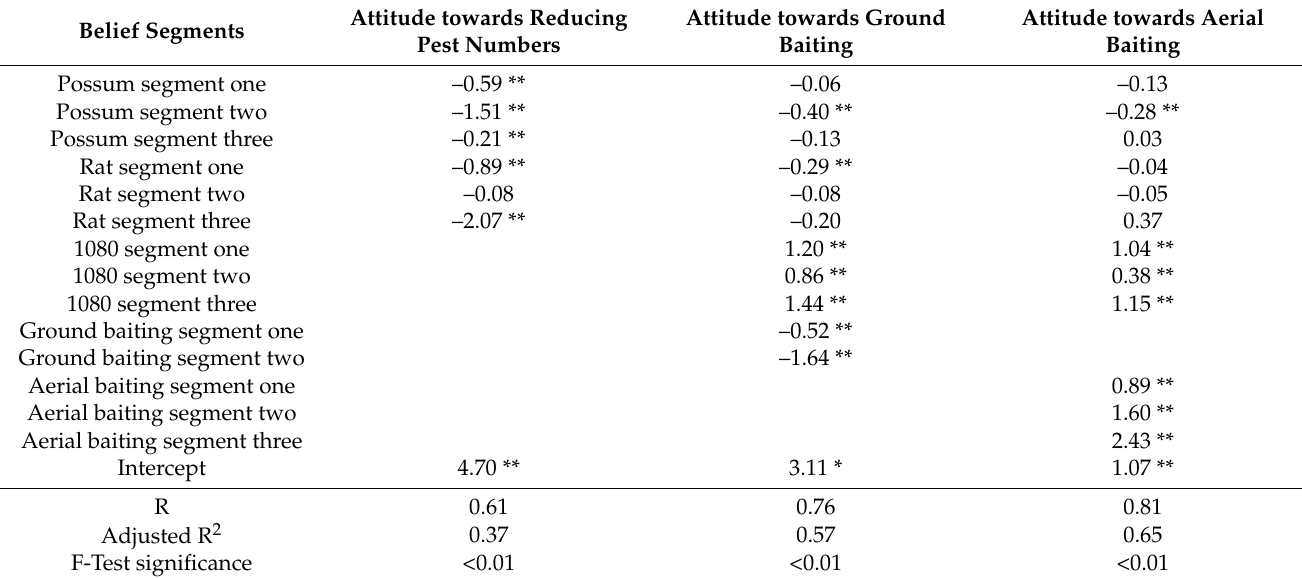
Table 6. Parameter estimates for attitude towards attitude towards reducing pest numbers, aerial baiting, and ground